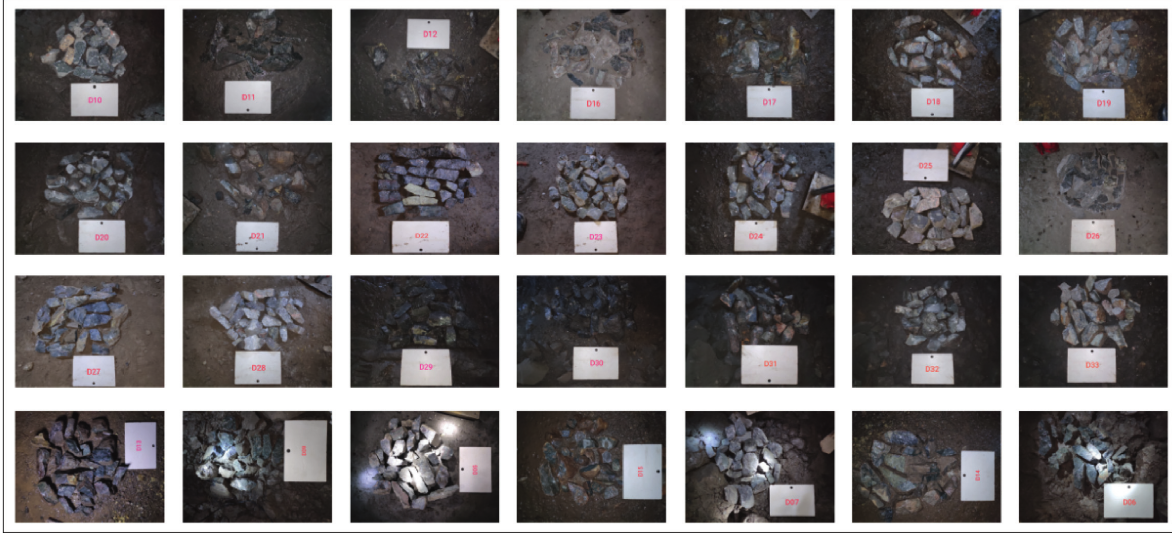
Figure 4: Site point load test after rock damage.